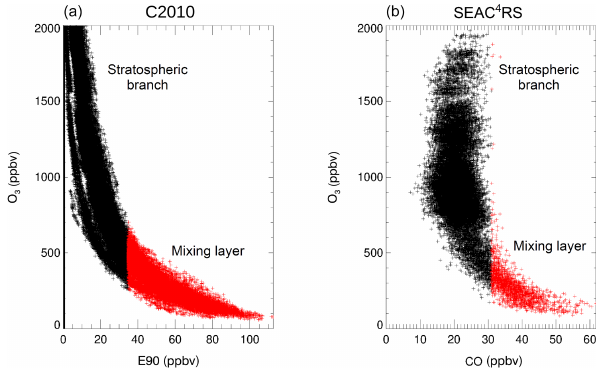
Figure 2. Tracer–tracer correlations for the results of case C2010 in a latitude range from 30–35 ◦ N (a) and SEAC 4 RS measure- ments (b) consist of a stratospheric branch (black) and of the mix- ing layer between stratospheric and tropospheric air masses (red). The mixing layer is determined to be located above the tropopause and showing more than 35ppbv E90 in case C2010 and more than 31ppbv CO in SEAC 4 RS